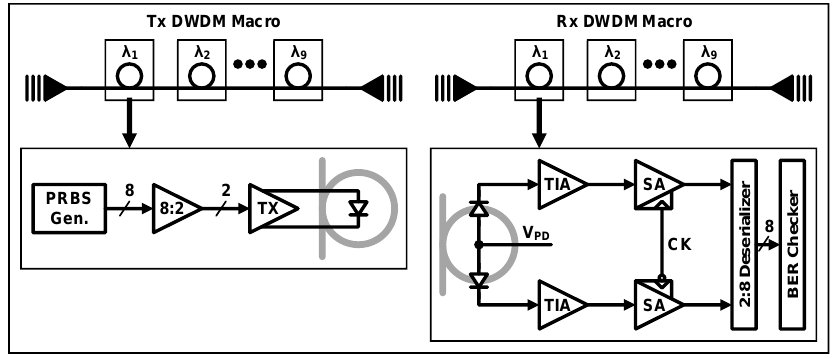
Figure 10. Monolithically integrated DWDM optical link in bulk CMOS [50].